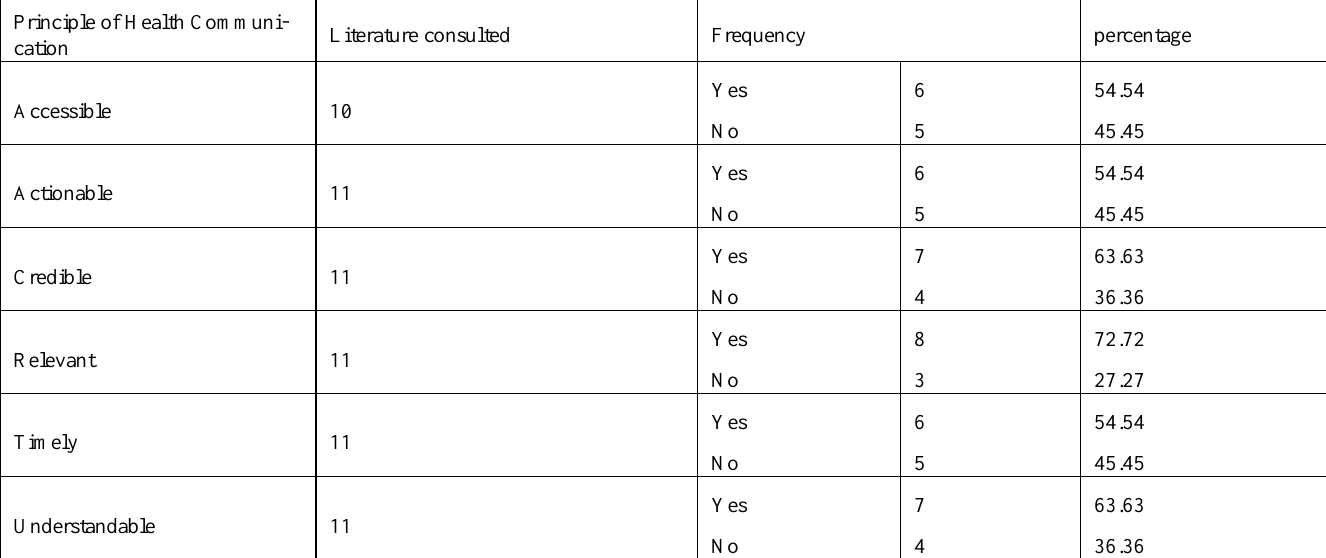
Table 1: NHIS application of the principle of effective Health Communication Principle of Health